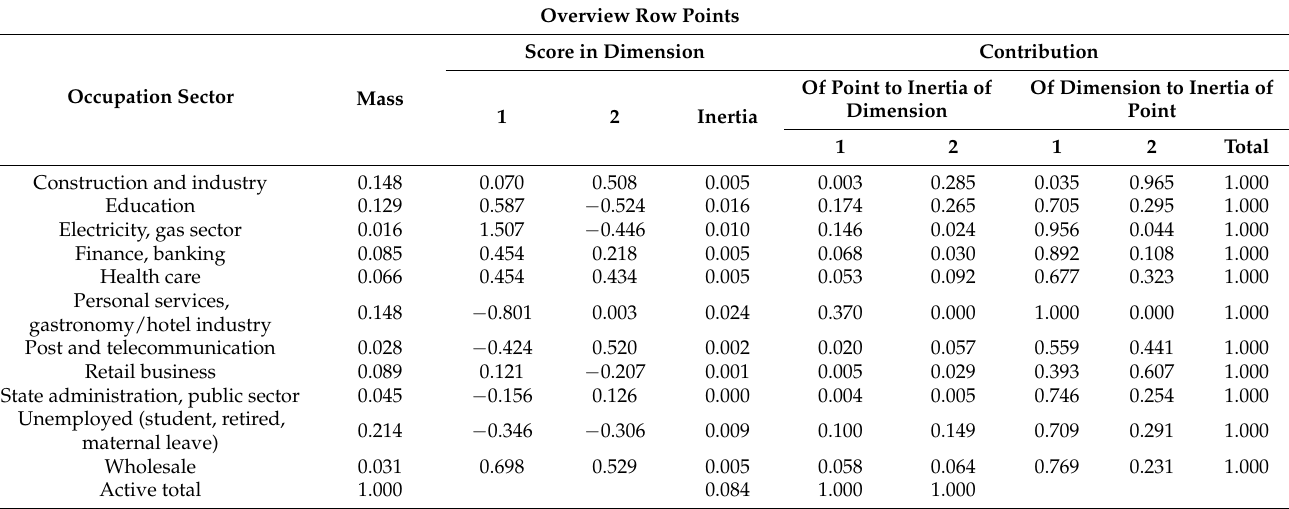
Table 5. Overview of row points (categories of occupation sector). Overview Row